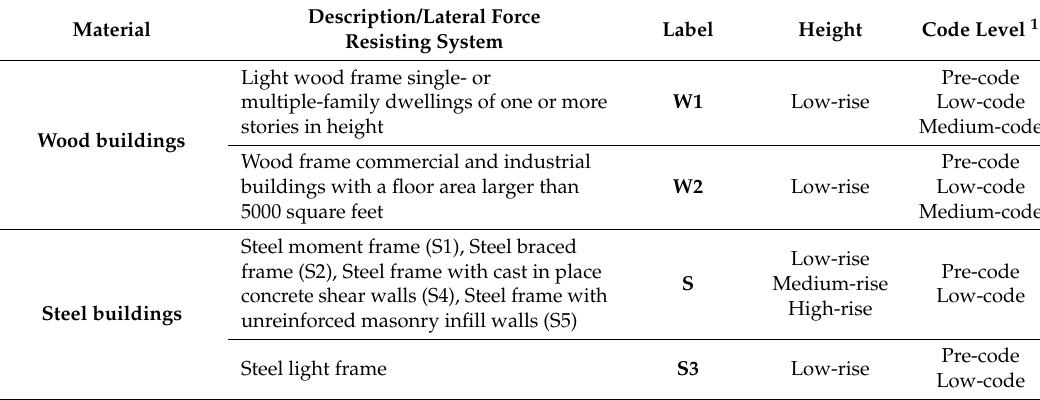
Table 3. Proposed simplified building